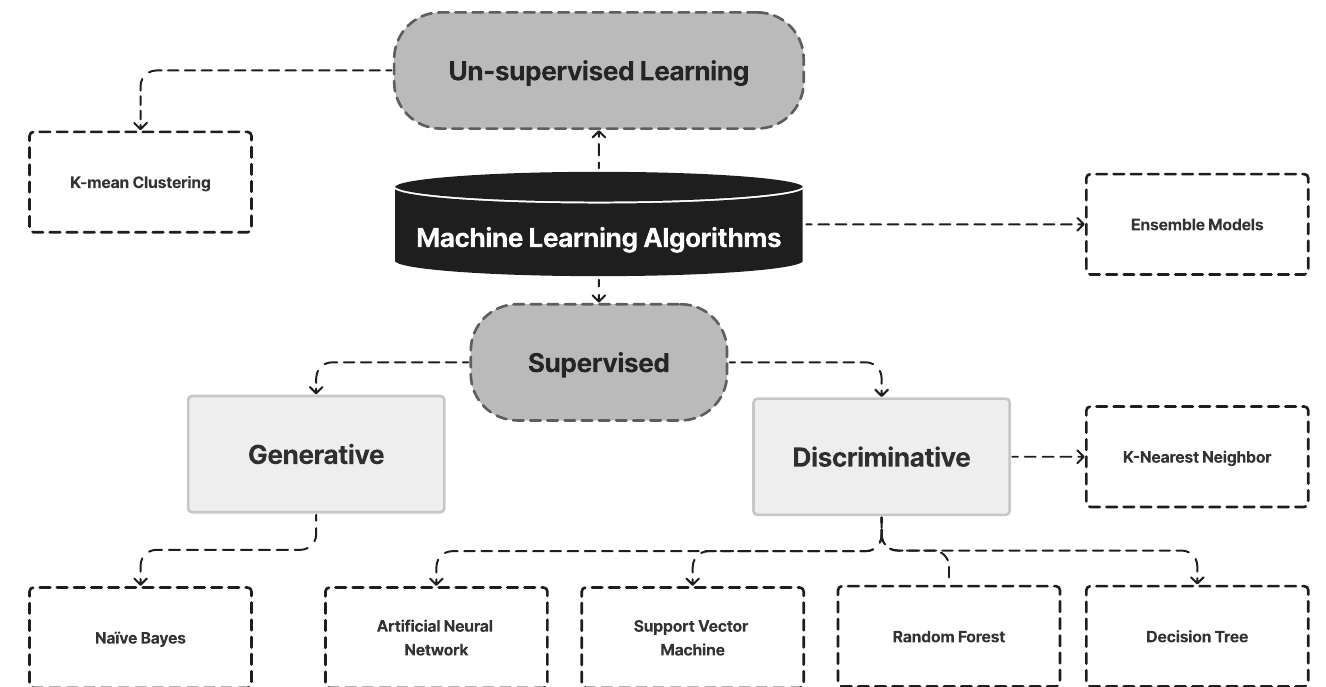
Figure 9. ML Models for Oral Cancer Diagnosis used in this review .